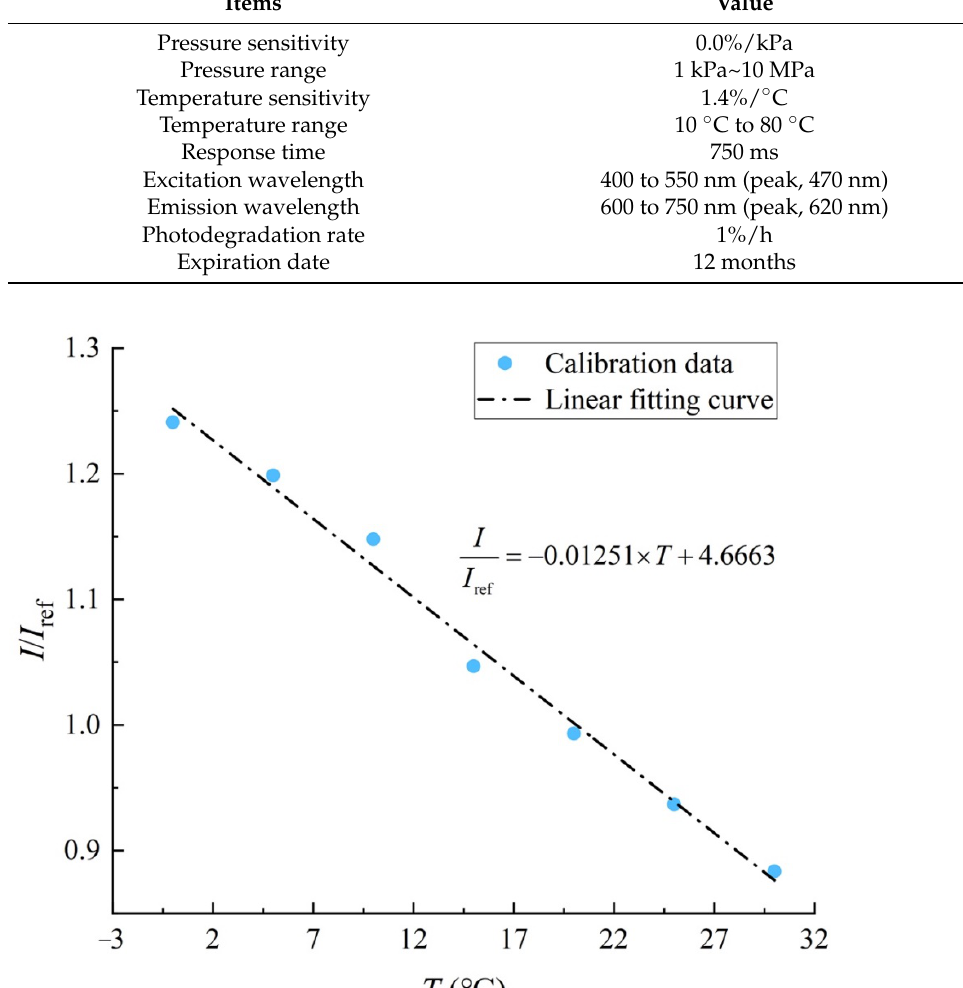
Table 1. Parameters of UNT-200 one-component TSP.